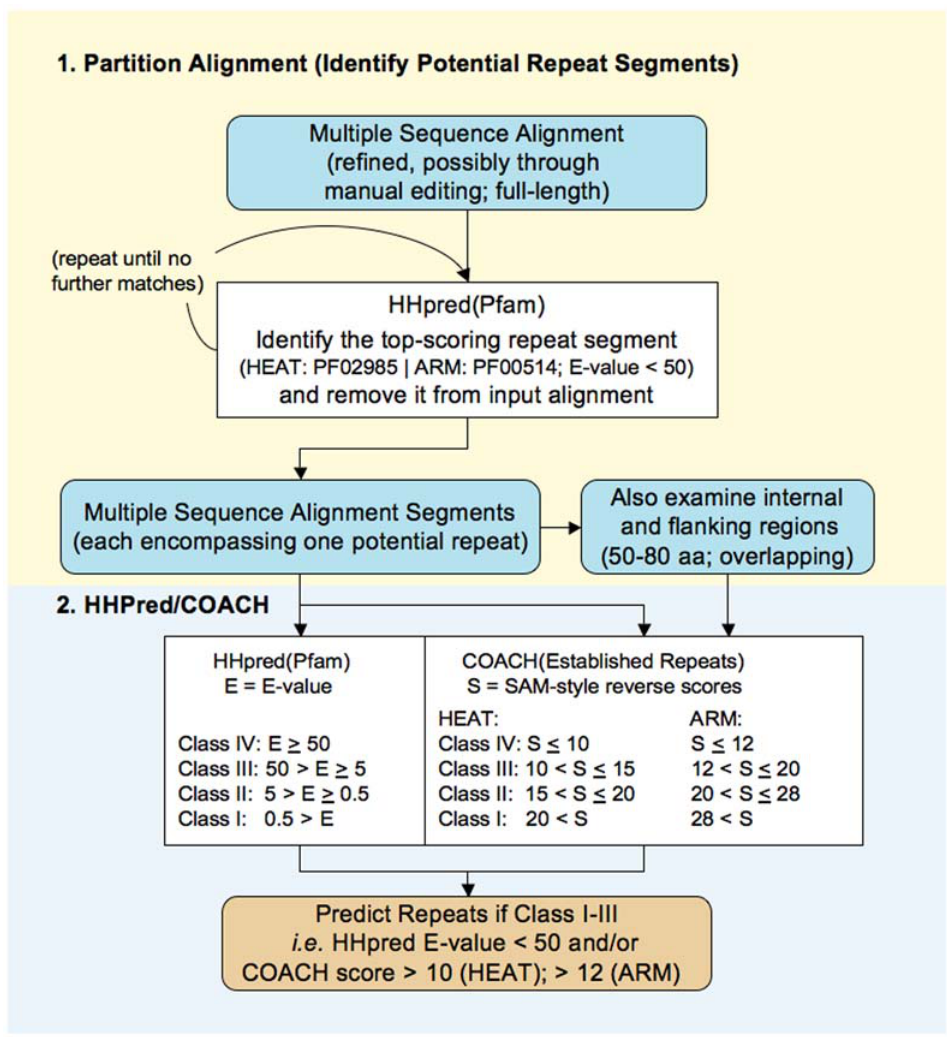
Figure 7. Protocol for repeat detection by HHpred and COACH. Flow chart of the protocol, for further details of the individual steps see